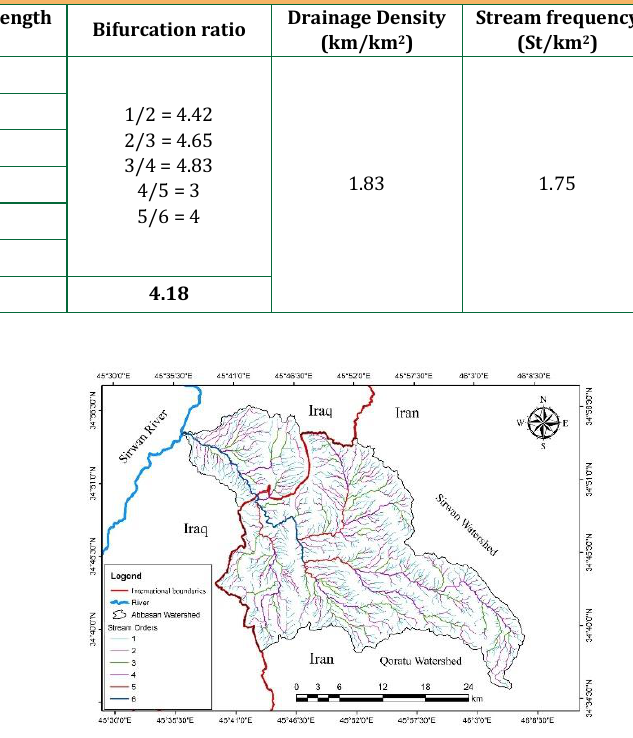
Figure 3: Stream orders and drainage basin of Abbasan